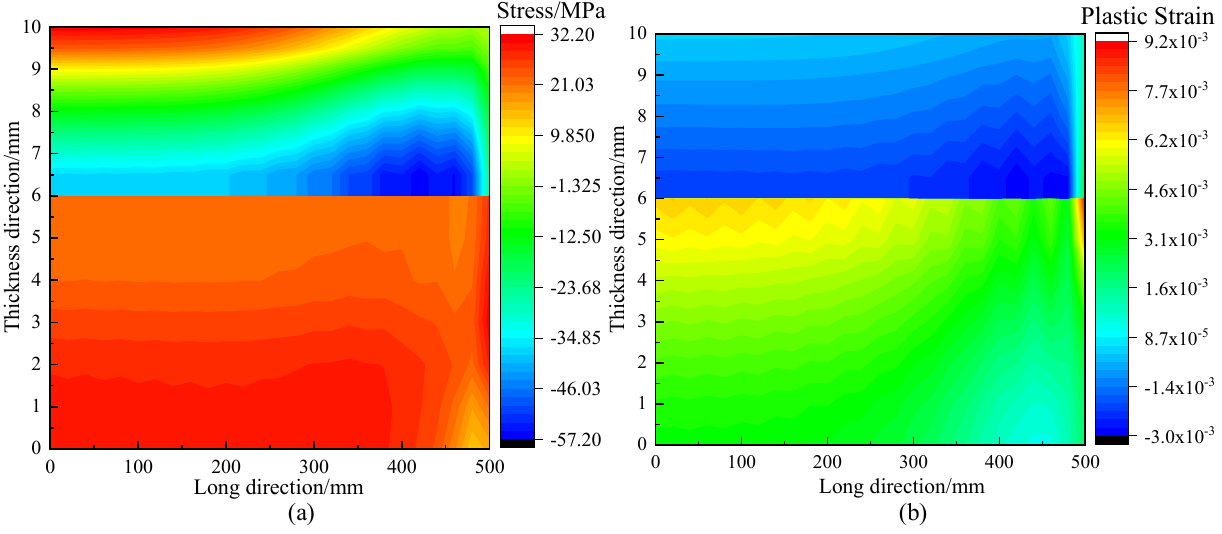
Figure 17. Distribution cloud diagram of longitudinal stress and plastic strain after holding process. ( a ) Longitudinal stress. ( b ) Longitudinal plastic strain.